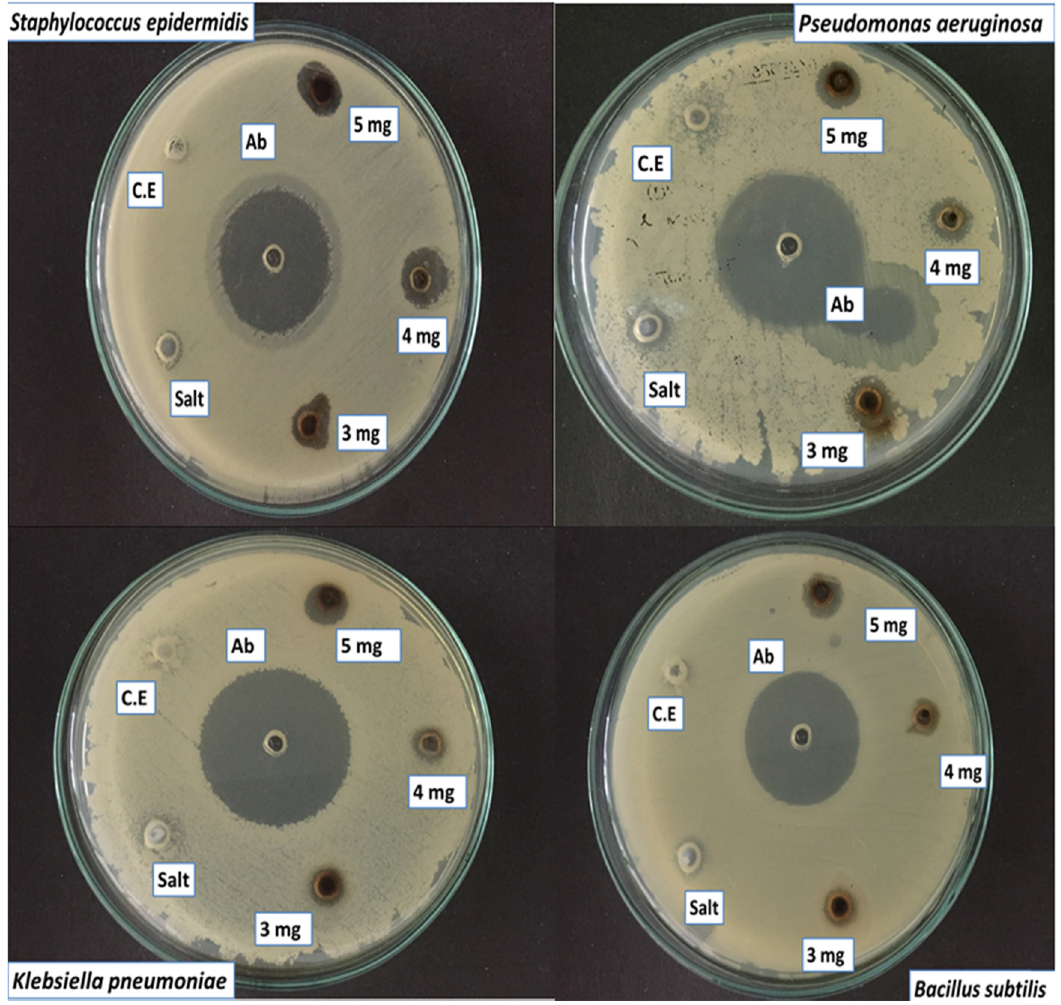
Figure 8: Antibacterial activity of Ag - NPs at di ff erent concentrations ( 5, 4, and 3 mg · mL − 1 ) ; Ab – antibiotics, CE – callus